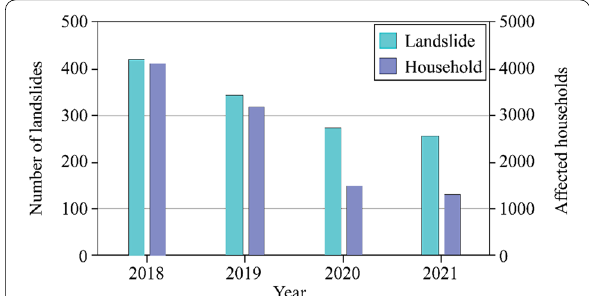
Fig. 3 Yearly occurrence of landslides and affected households in the Kutupalong Rohingya camp. Data Source IOM